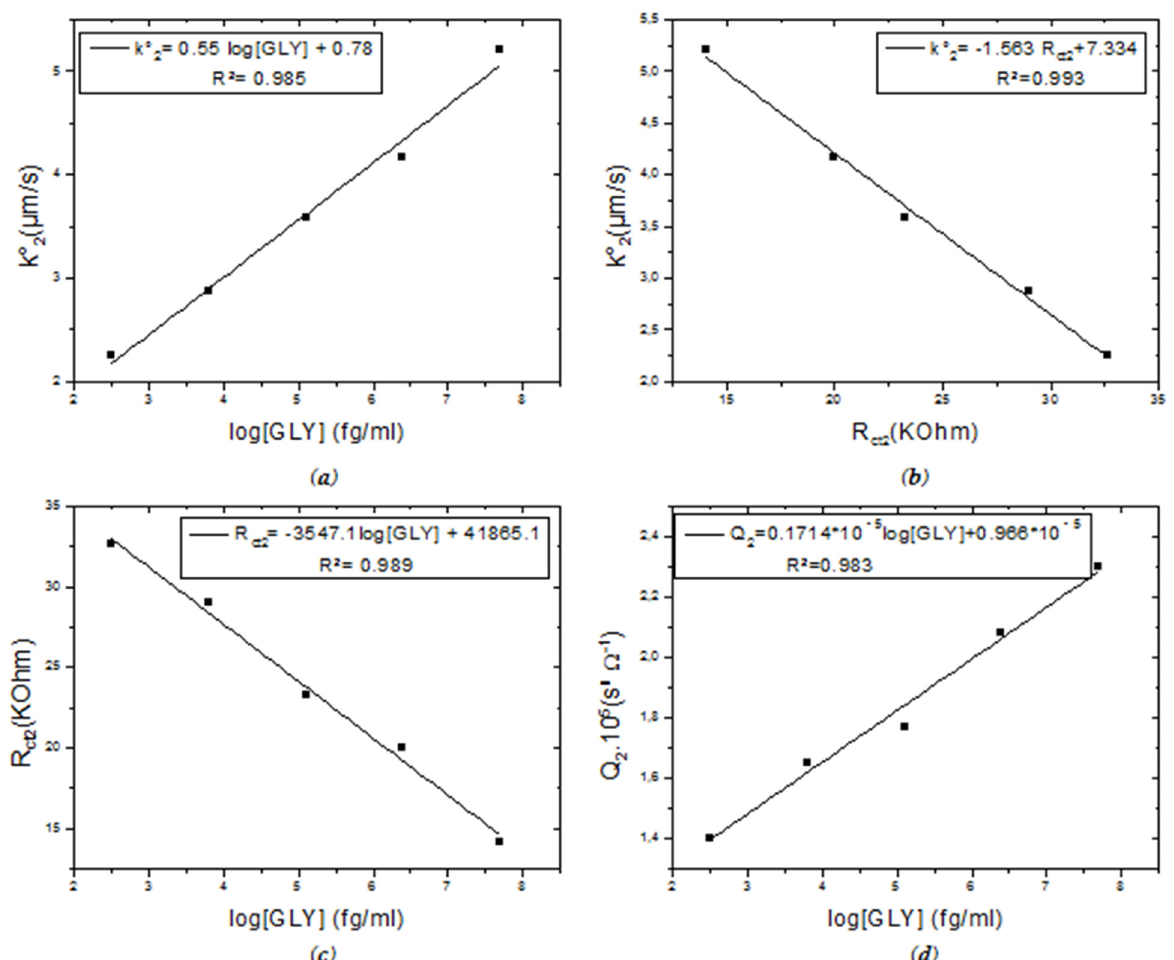
Figure 4. Calibration curves of CS ‐ MIPs/CMA/Au. ( a ) k 2 ° = f(log[GLY]), ( b ) k 2 ° = f(Rct2) for different [GLY], ( c ) R ct2 = f(log[GLY]), ( d ) Q 2 = f(log[GLY]). ([GLY] = 0.31 pg/mL–6.25 pg/mL–125 pg/mL–2.5 ng/mL–50 ng/mL).